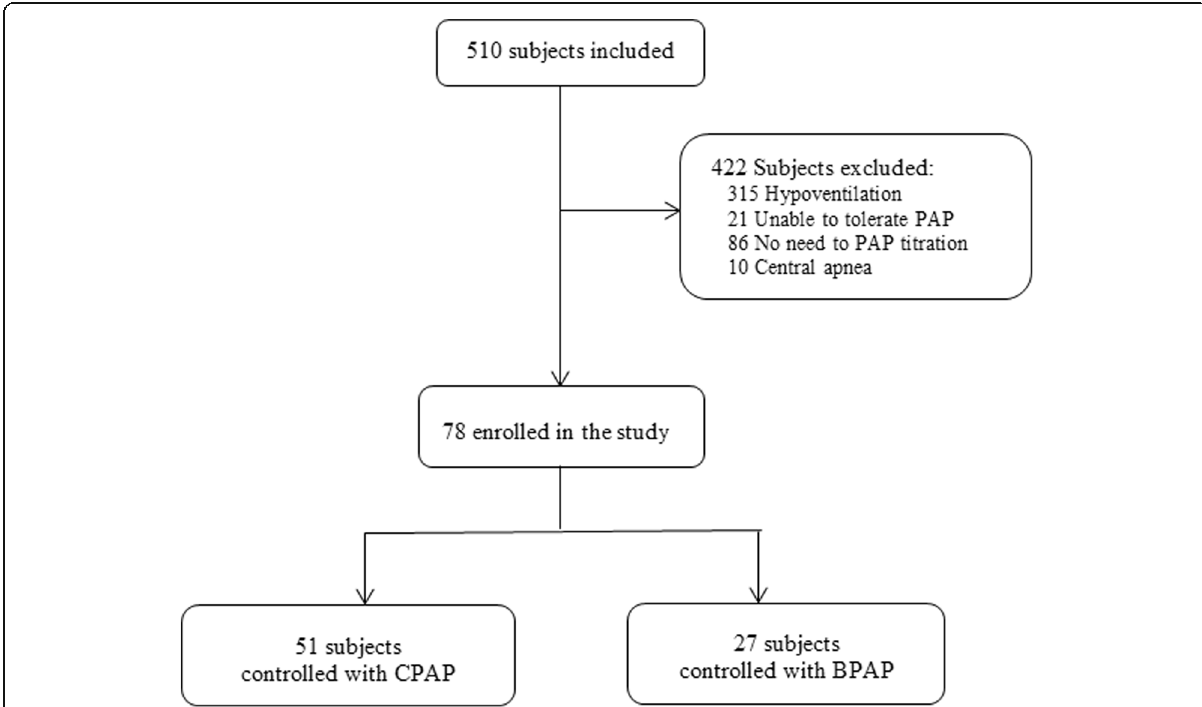
Fig. 1 flow chart showing included and excluded participants with finally 78 participants categorized as CPAP and BiPAP